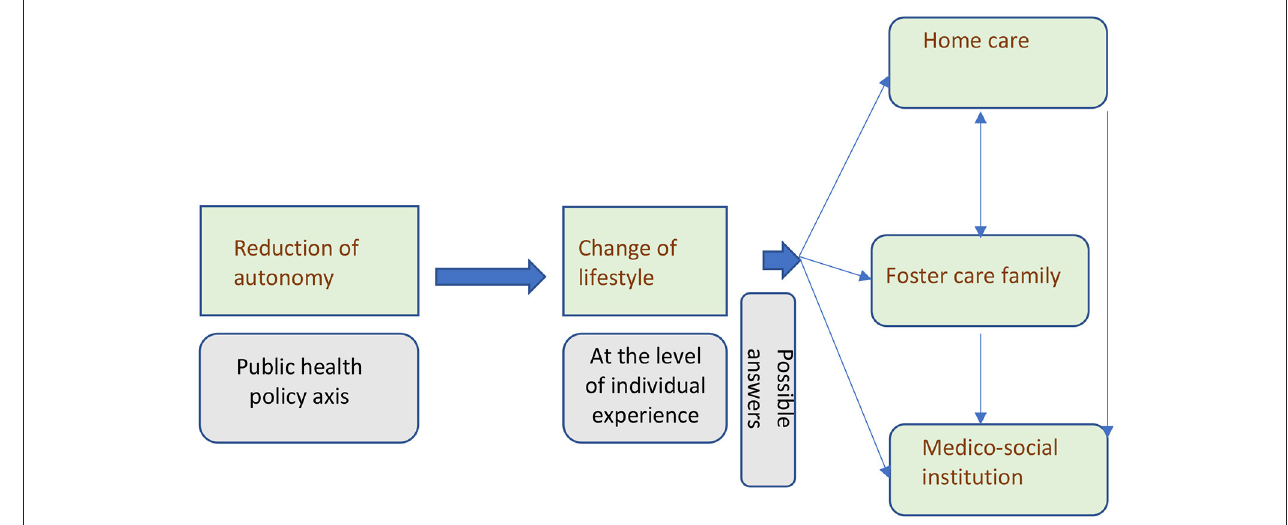
FIGURE 1 | Loss of autonomy and change of